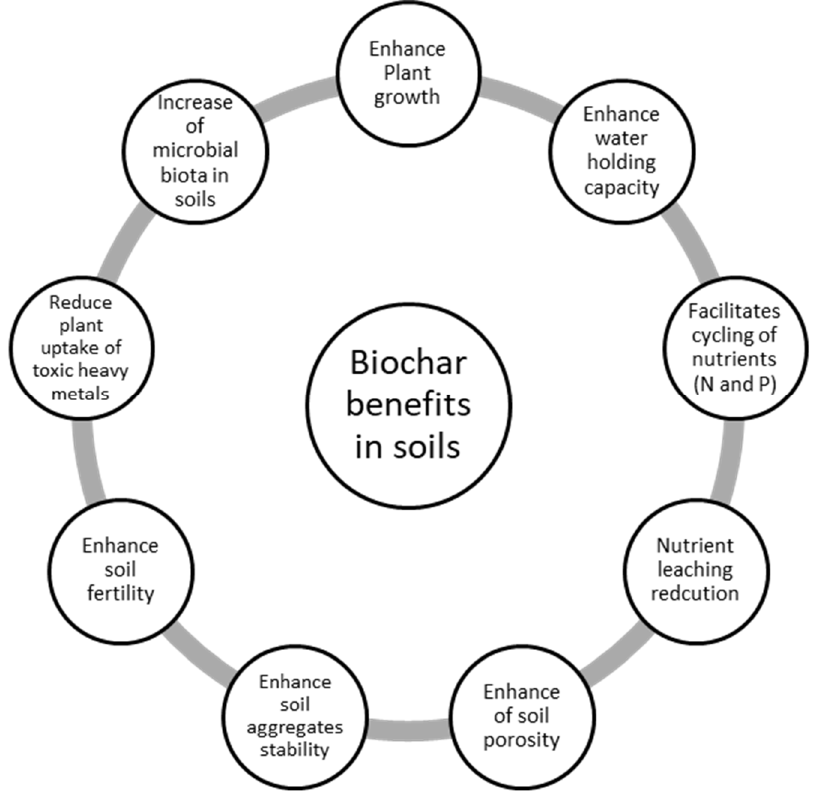
Figure 1. Potential biochar benefits in soils. Adapted from [9,10,12].